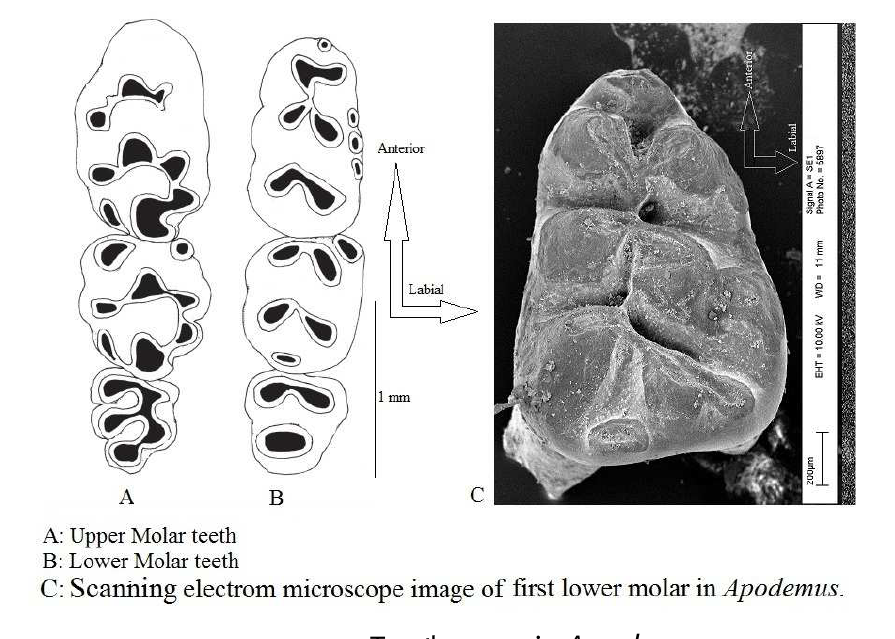
FIGURE 12 : Teeth rows in